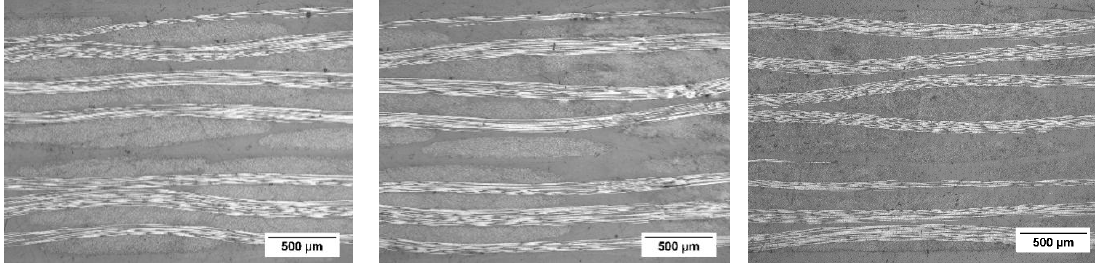
Figure 5. Optical microscopy of the laminates with TETA, IPDA, and DDS (left to right).